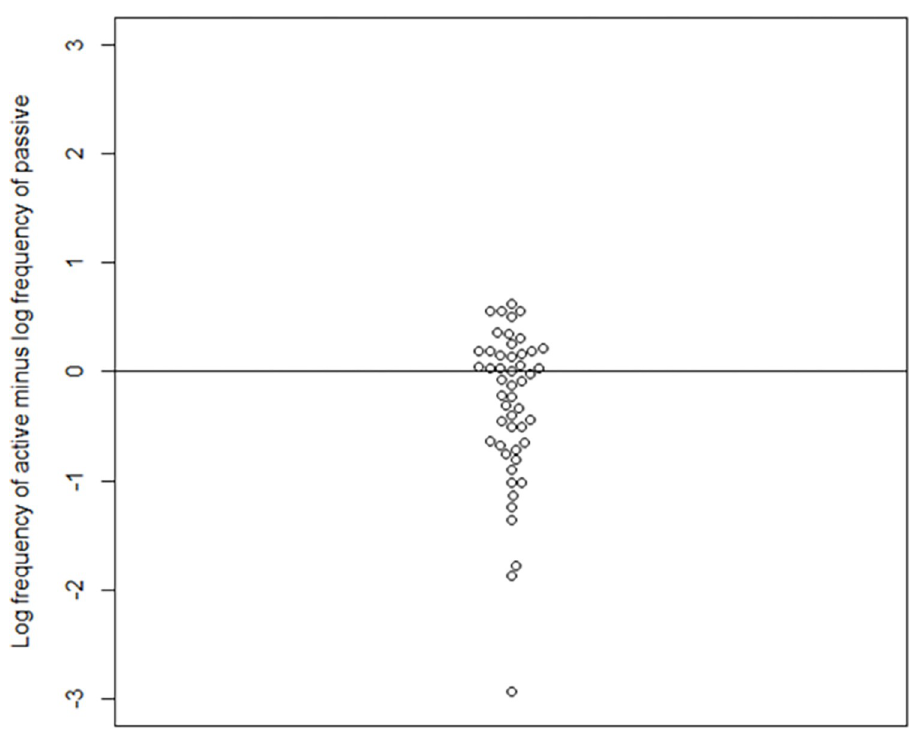
Fig 2. Beeswarm plot of log-transformed difference between active and passive